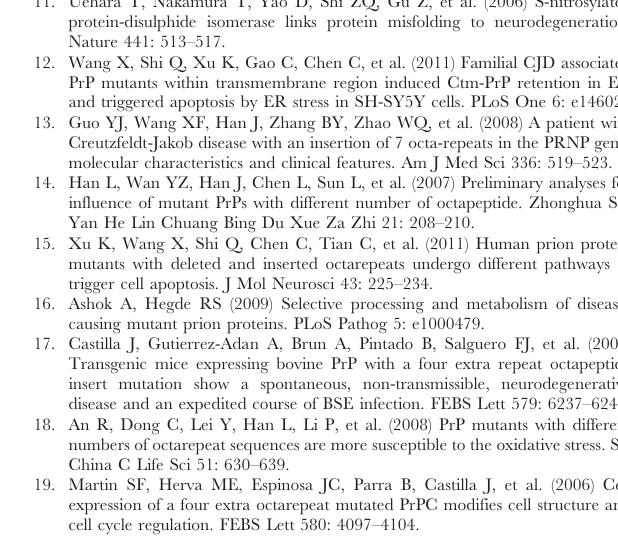
Figure S2 Influences of expressions of PS1-KDEL, PrP-G114V and PrP-PG14 on the cell viability and the relevant cellular factors. A. Cell viabilities assayed by CCK-8 kit. Each group is assigned to three repeating parallel units and measured with a spectropho- tometer under 450 nm. The results are indicated as mean 6 SD. Statistical differences compared with controls are illustrated as *P , 0.05. B. Western blots. Cell lysates were separated in 15% SDS-PAGE and the specific immunoblots for Grp78, pro- caspase12, PDI, pro-caspase3 and PrP were detected with individual antibodies. C. Quantitative analysis of each gray numerical value of Grp78, pro-caspase12, PDI, pro-caspase3 vs that of individual b -actin. The results are calculated from three independent tests presented as mean 6 SD. Statistical differences are illustrated as *P , 0.05. Figure S3 Caspase-3 activity assays of various preparations with a commercial kit. 2 U/ m l of recombinant human capsase-3 (marked as Caspase-3) supplied in the kit was used as the positive control. ABS indicates as absorbance at 405 nm. Test was repeated for three times. Data are shown as mean values 6 SD. Statistical differences are illustrated as *P ,